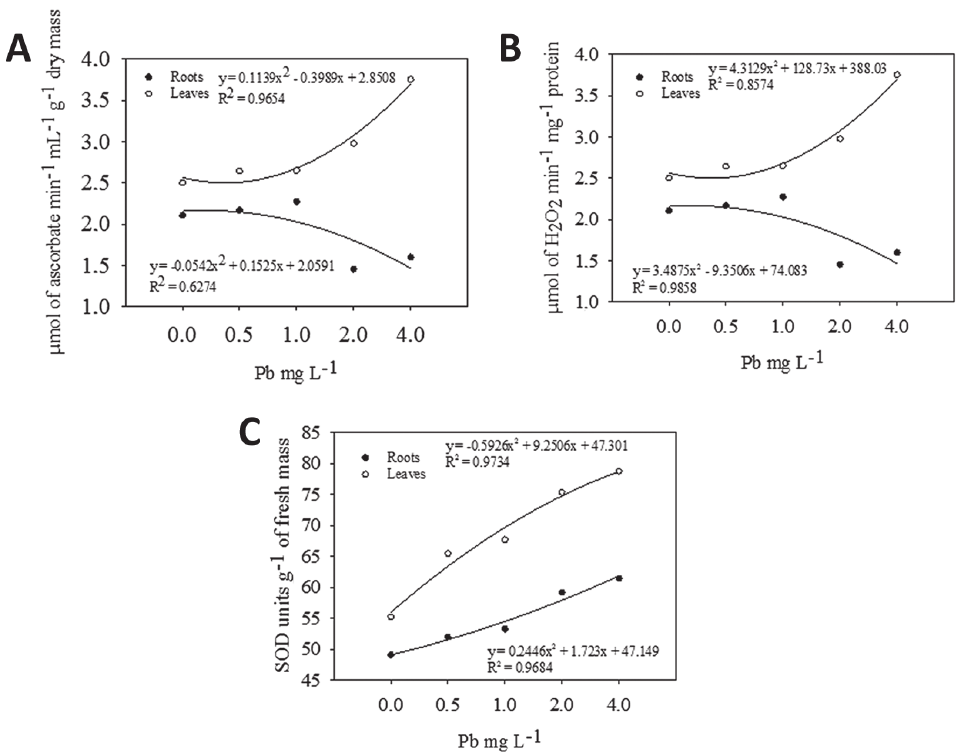
Figure 4 - Antioxidant enzyme activities of Eichhornia crassipes grown in nutrient solutions containing different lead concentrations. A = Catalase activity, B = Ascorbate peroxidase activity, C = superoxide dismutase activity. Bars = standard